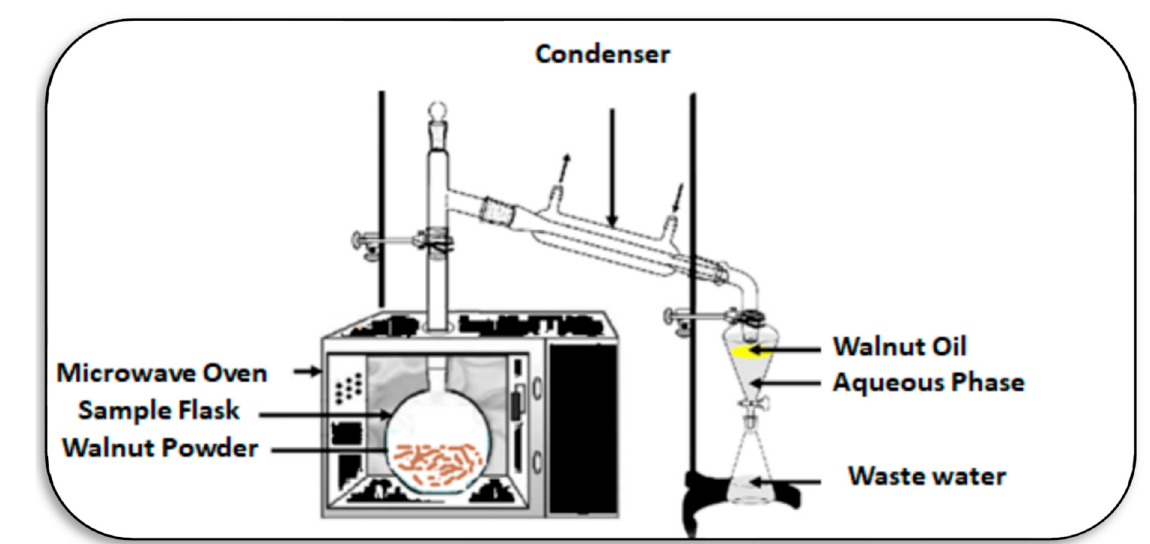
Figure 5. Microwave assisted walnut oil extraction .